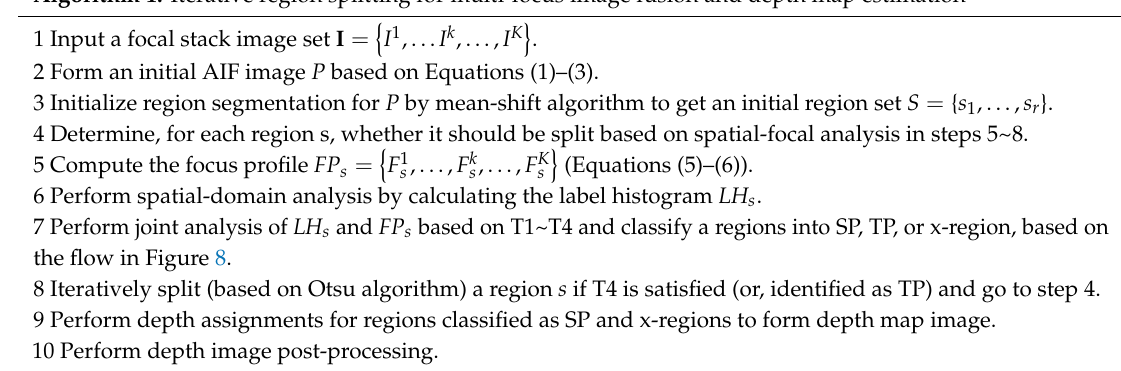
Algorithm 1: Iterative region splitting for multi-focus image fusion and depth map estimation